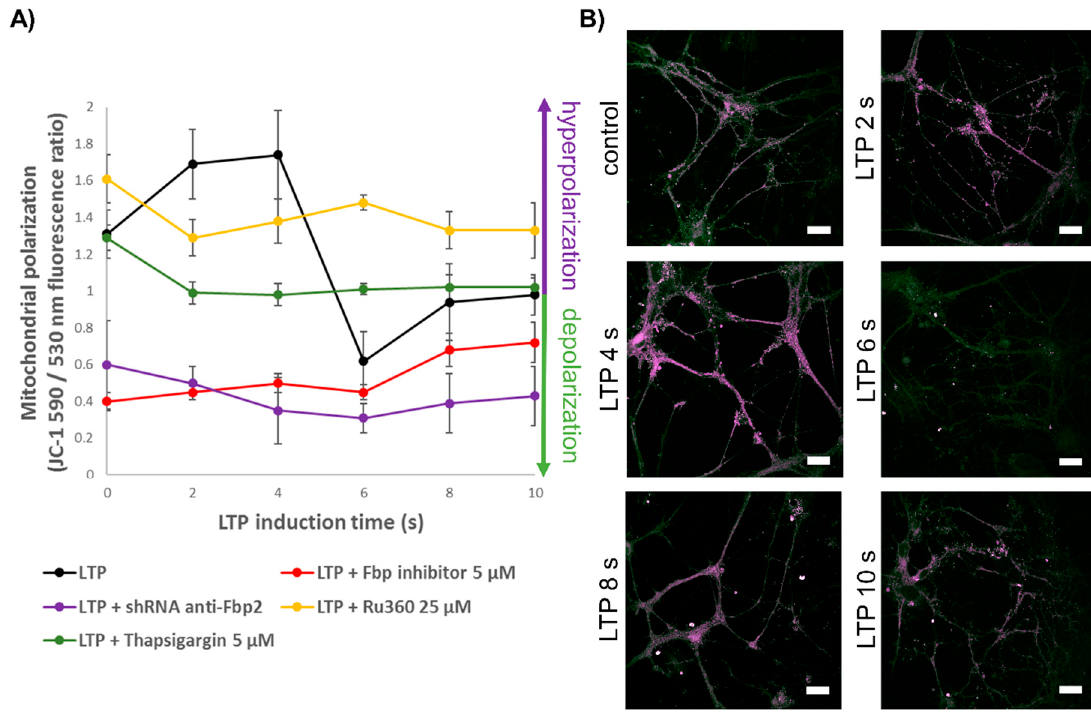
Figure 3. LTP-associated changes in mitochondrial membrane polarization. ( A ) Induction of LTP results in a short event of mitochondrial hyperpolarization followed by a period of their depolarization. Inhibition/tetramerization of Fbp (red line) as well as its silencing (blue line) results in depolarization of mitochondria. In the presence of thapsigargin (an inhibitor of the sarco/endoplasmic reticulum Ca 2+ -ATPase; green line) or Ru360 (an inhibitor of Ca 2+ uptake to mitochondria; yellow line), mitochondria are weakly hyperpolarized and depolarized, respectively, as compared to basal polarization (at time 0). Except in the control conditions (no inhibition/tetramerization or silencing of Fbp; black line), the induction of LTP does not affect mitochondrial polarization. ( B ) Time-dependent changes in mitochondrial polarization after the LTP induction. Bar = 20 μ m. The values are given as a mean and SD. N = 30 ROIs.